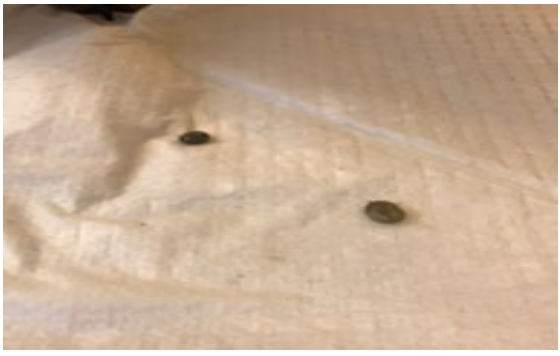
Fig. 1. Ixode mites on the litter Fig. 2. Ixode mites on the dog's body